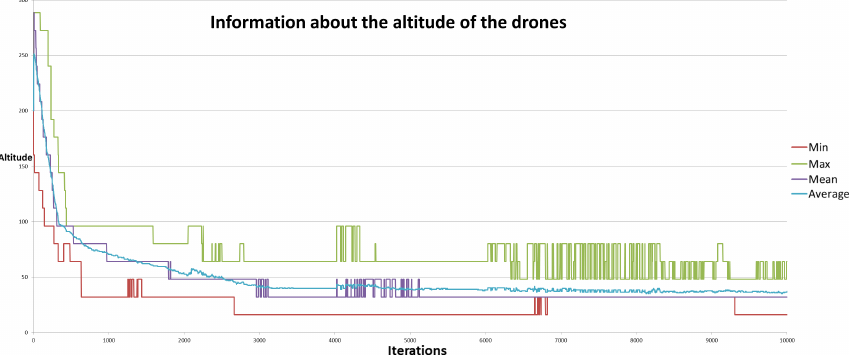
Figure 7. The altitudes of the UAVs in the surveillance swarm under the changing resolution requirements (cf. Fig. 5).